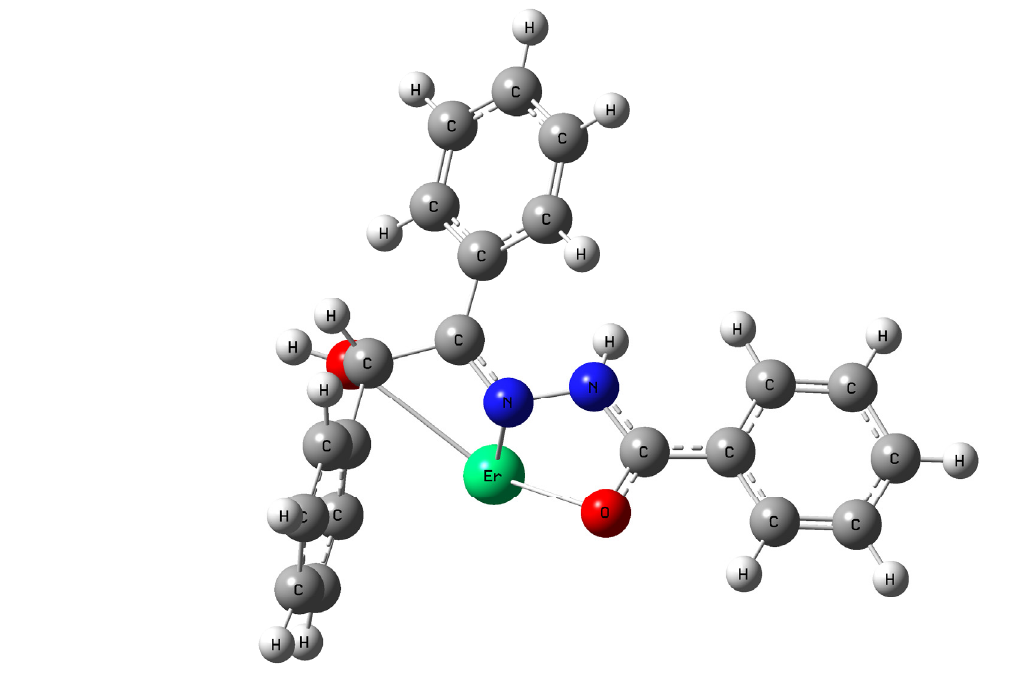
Figure 3. Optimal conformation of ionophore after complexation with Er 3+